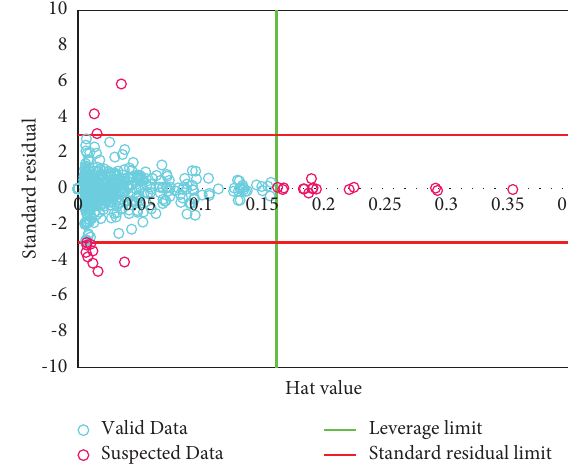
Figure 7: Identifcation of